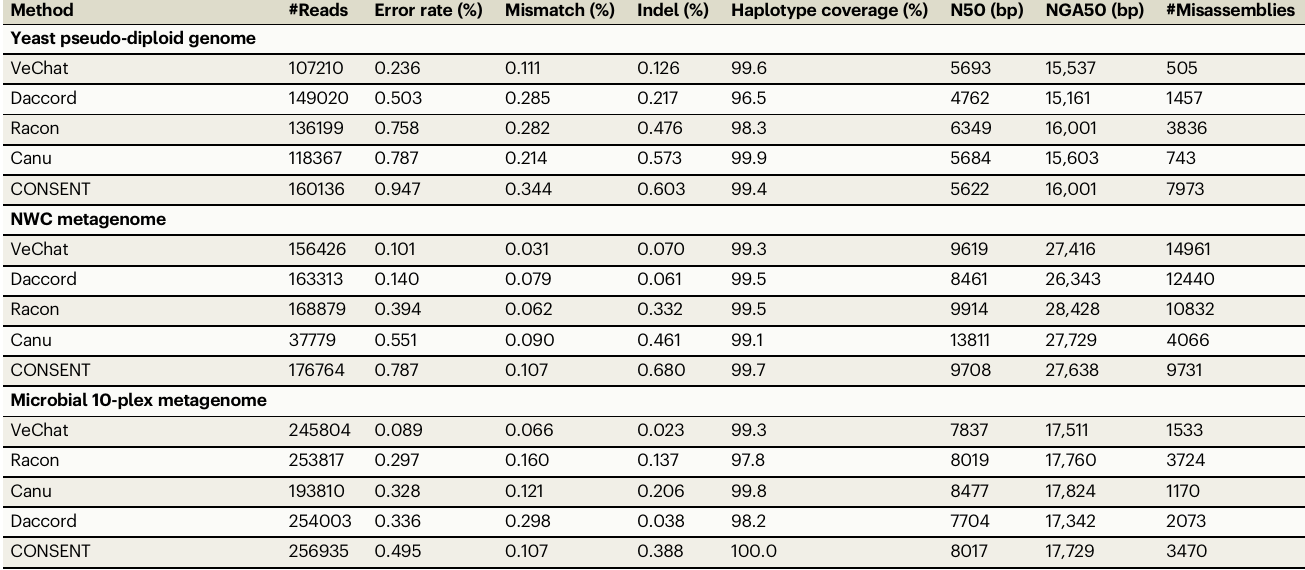
Table 4 | Error correction benchmarking results for real PacBio sequencing data (mock communities) Method #Reads Yeast pseudo-diploid